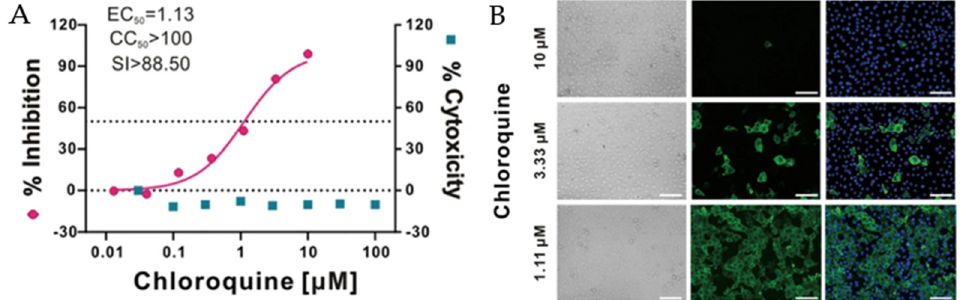
Figure 18. ( A ) Percentage of inhibition measured by qRT-PCR and cytotoxicity of Chloroquine ®